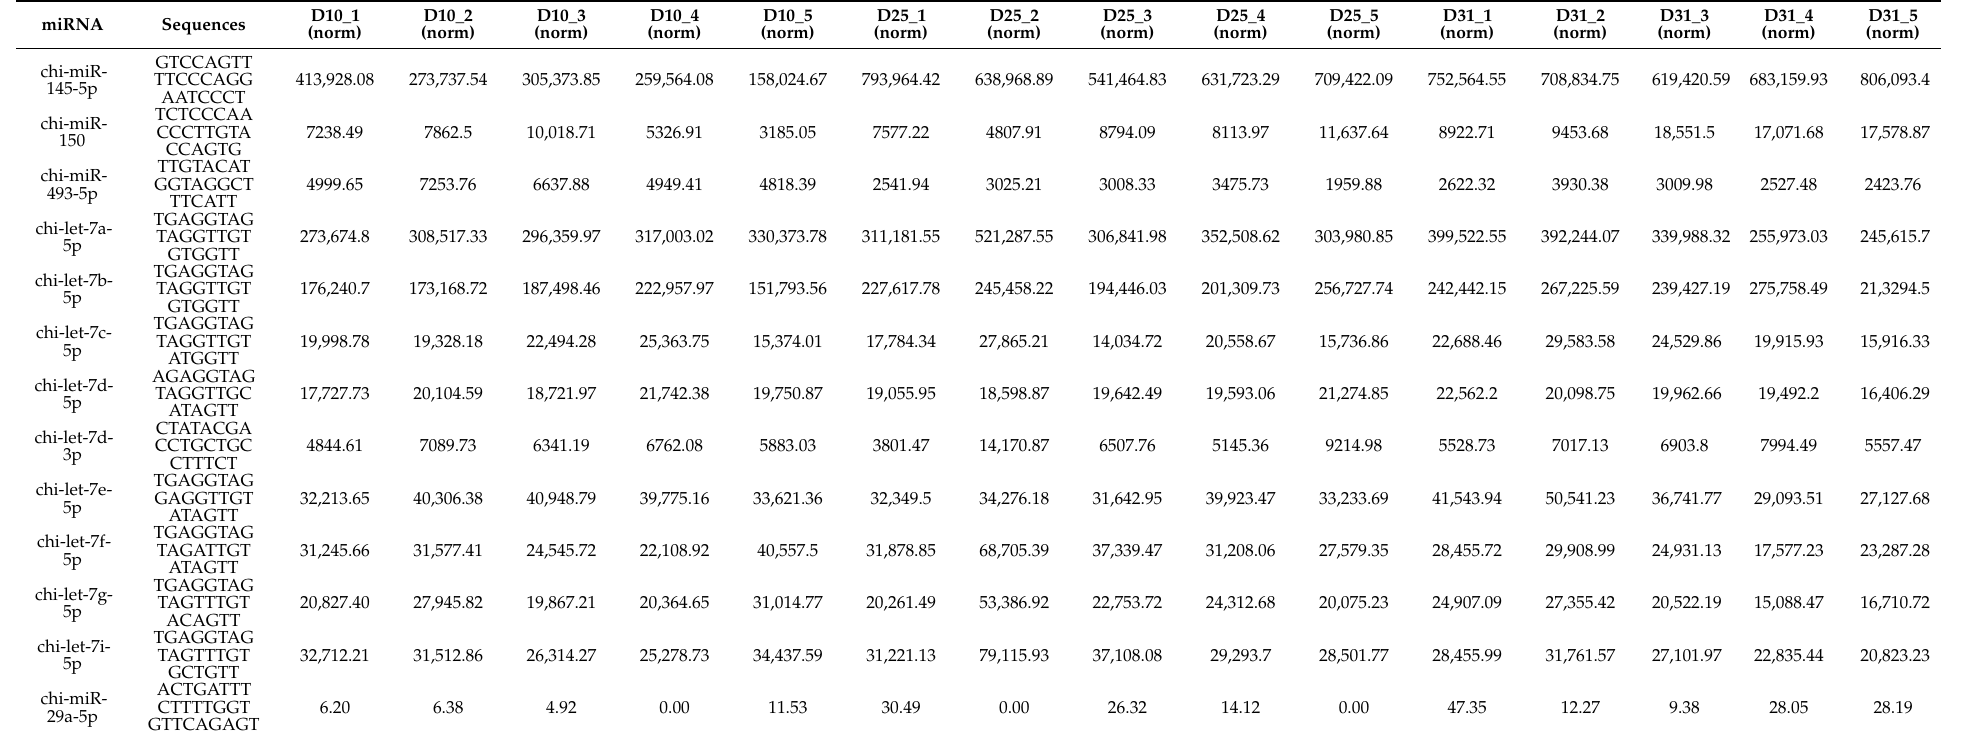
Table 1. Key miRNAs in the colon of goats at the preregurgitation